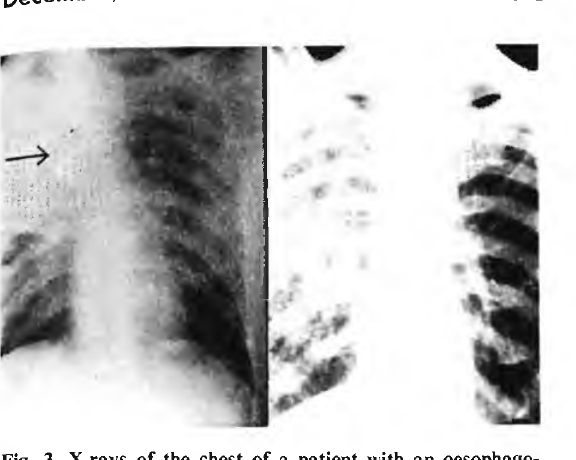
Fig. 3. X-rays of the chest of a patient with an oesophago- mediastinal fistula. (a) Barium Meal demonstrates the fistula. (b) The mediastinal abscess resulting from this fistula.